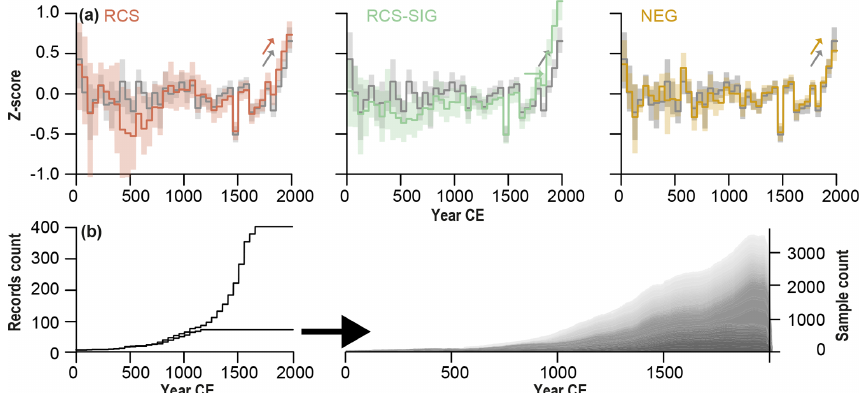
Figure 6. Effects of tree-ring detrending on long-term trends. (a) Fifty-year binned composites from 67 RCS (red), RCS-SIG (green), and NEG (gold) standardized datasets. The PAGES2k composite (dark gray) includes the corresponding chronology versions that are provided in the 2.0.0 database. Shadings indicate 95% bootstrap confidence intervals with 500 replicates, and the arrows indicate the direction of the post-1800 trend. (b) Temporal distribution of the NH tree-ring samples (402) relative to the detrended subset (67) and distribution of individual samples from records included in the subset (gray shadings).